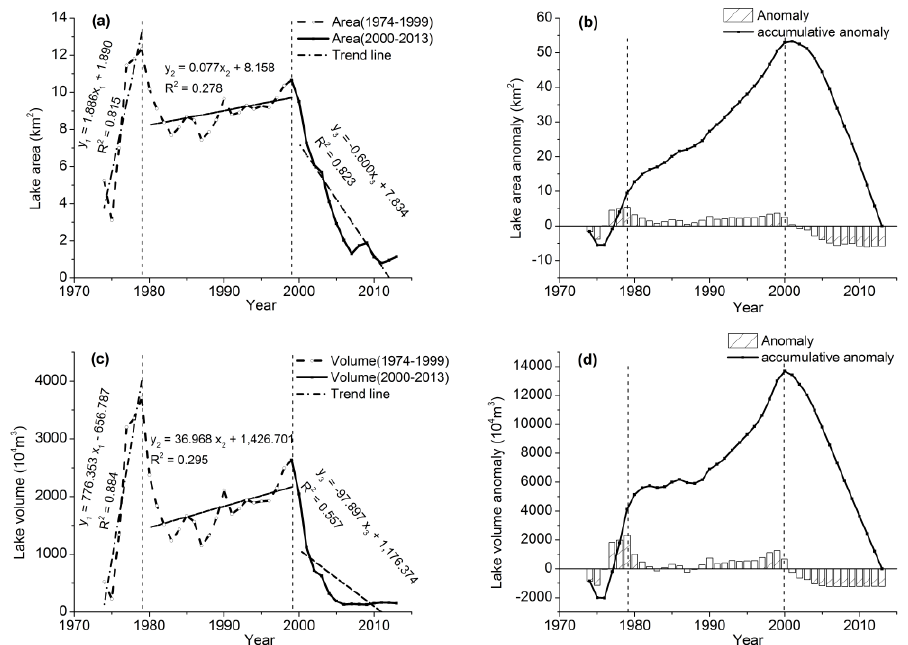
Figure 3. Variations of ( a ) average annual lake area, ( b ) annual anomaly and accumulative anomaly, ( c ) average annual lake volume, and ( d ) anomaly and accumulative anomaly of volume in the Erdos Larus relictus National Nature Reserve (ELRNNR).